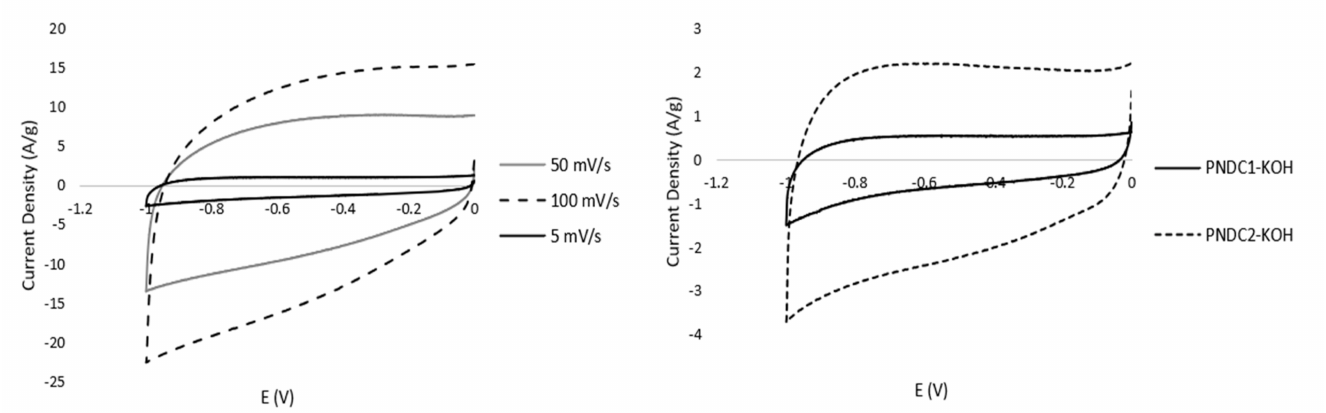
Figure 4. Cyclic voltammograms in 6 M (KOH) for PNDC2 at varying scan rates (left) and PNDC1 compared to PNDC2 in 6 M KOH electrolyte at a scan rate of 5 mV/s (right).